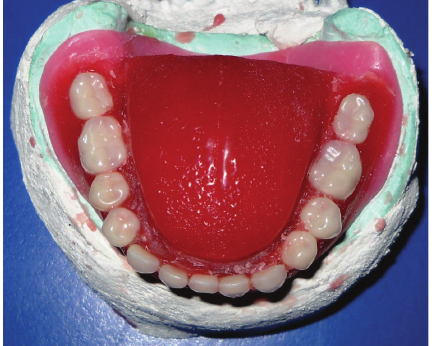
Figure 1: Preoperative intraoral view.